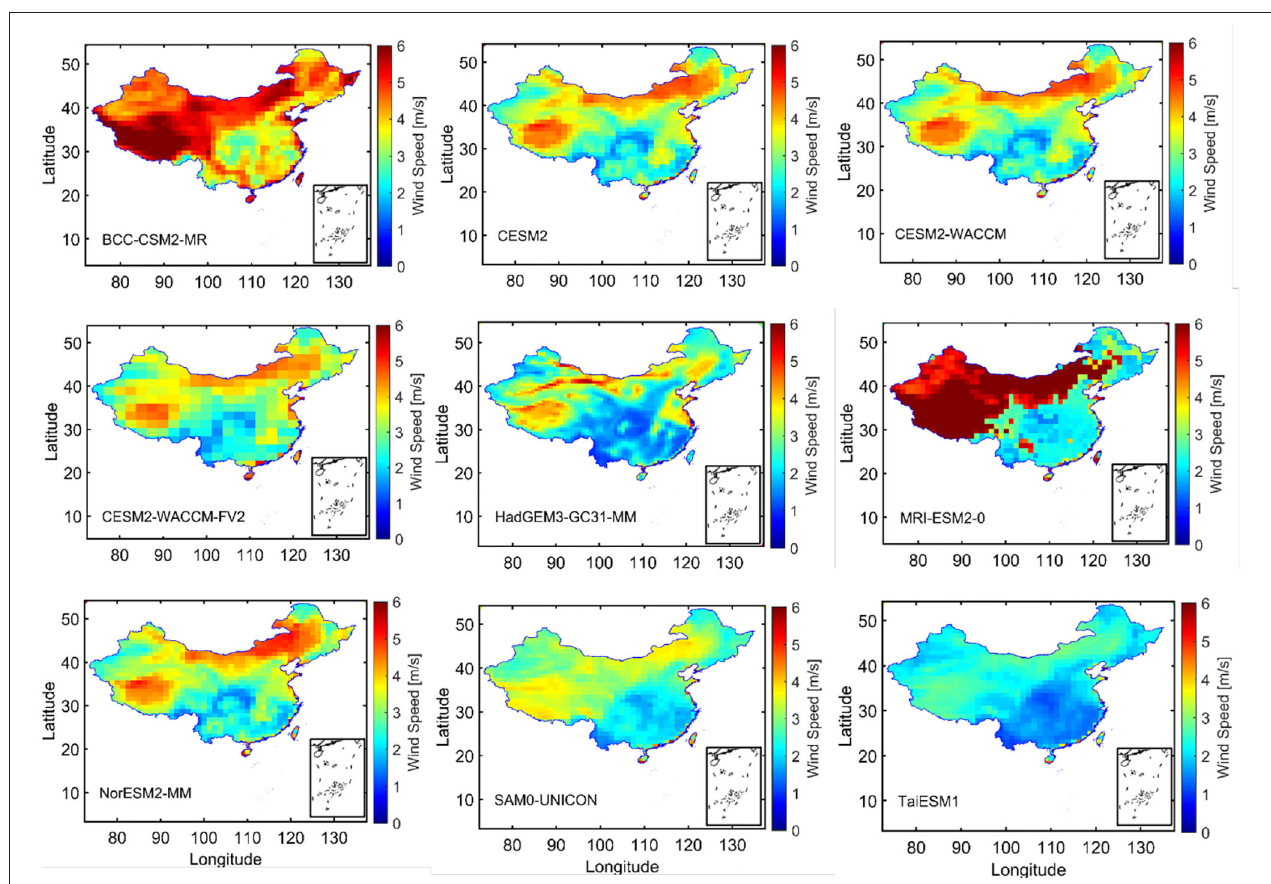
FIGURE 2 | Spatial distribution of mean 10-m wind speed (1986–2014) in CMIP6 historical simulations.